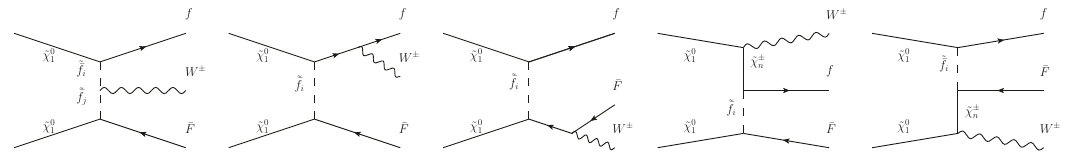
Figure 4 . Same as (cid:12)gure 2, but mediated by t -channel